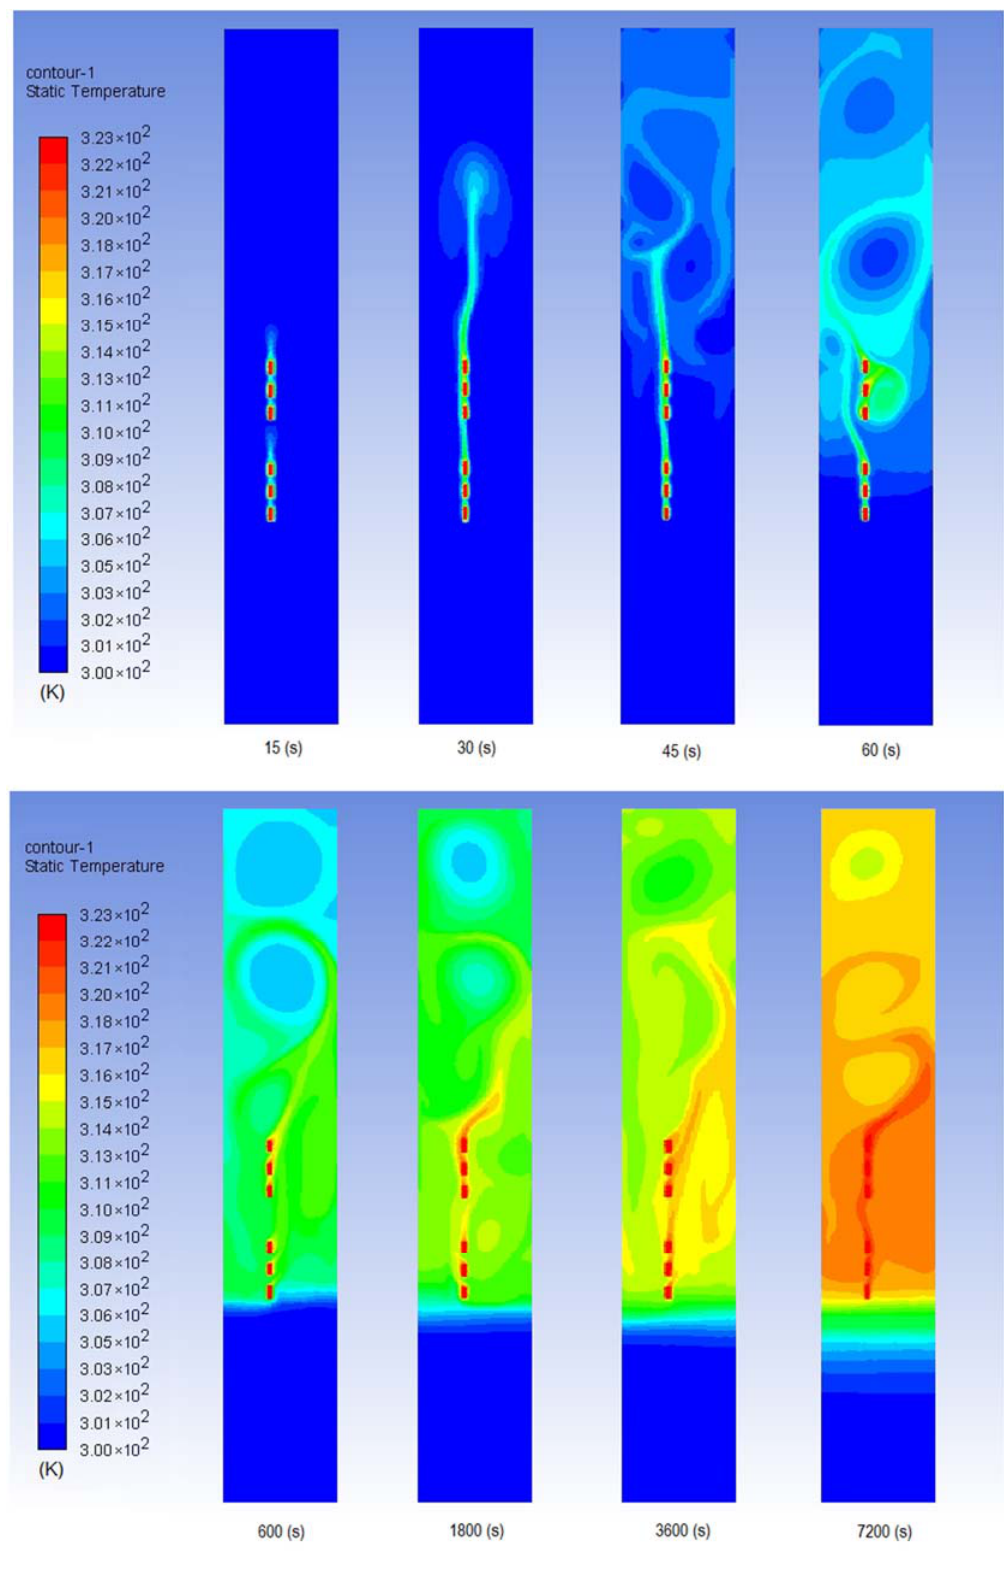
Figure 11. The convective distribution of heated air inside the switchgear.